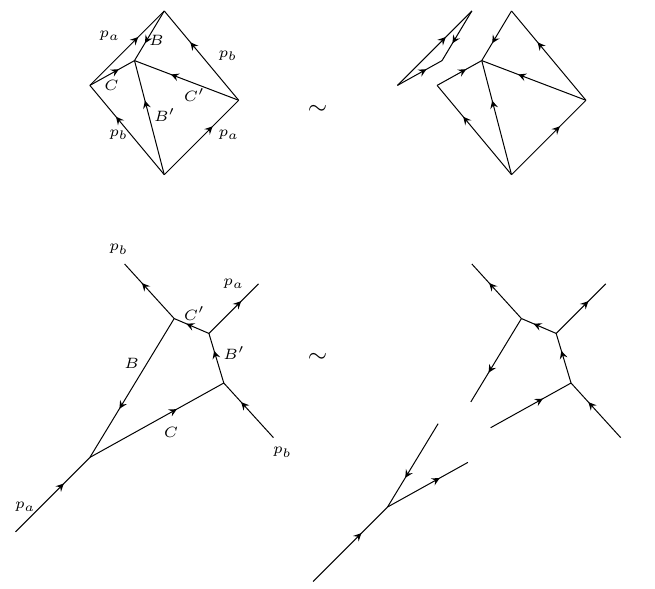
Figure 4 . Singular part of the box integral written as the product of a vertex and a tree-level 5 - point diagram. The Jacobian i is omitted in the picture. Note that, both here and in figure 2, 8∆ BC the faces of the dual diagram are mapped to the vertices of the Feynman diagram only after the former has been rotated by 90 ◦